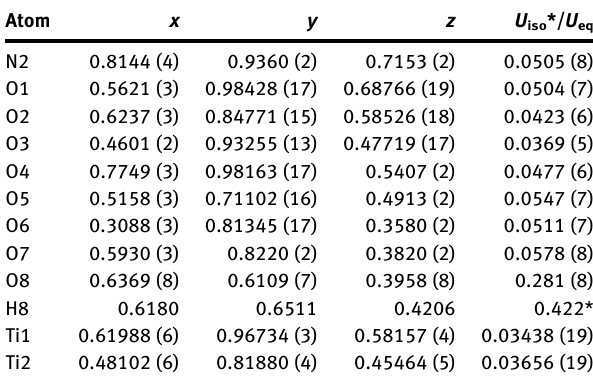
Table  : Fractional atomic coordinates and isotropic or equivalent isotropic displacement parameters (Å 